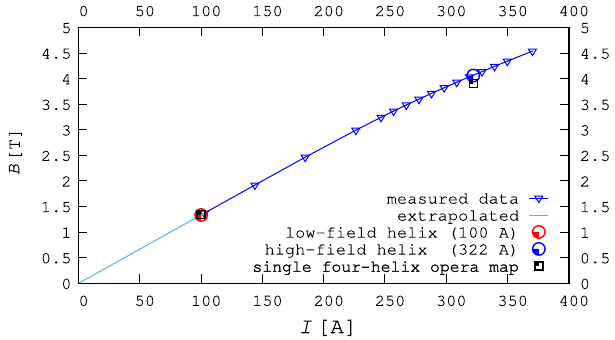
FIG. 5. Numerical data used for the normalization of OPERA currents to real-life currents. Blue triangles: from field measure- ments in a prototype 360°-twist helical dipole. Red circle: low- field helix map, case of 100 A OPERA current; Blue circle: high field helix map, case of 322 A OPERA current. Black squares: a case of a 12 m extent OPERA model of a complete snake ; I Þ ¼ ð 100 ; 322 A Þ [12]. computed with ð I out in